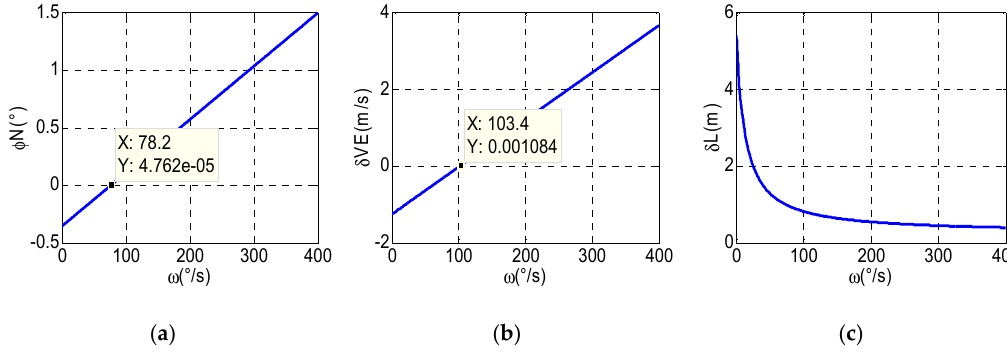
Figure 4. ( a ) The relationship curve of north attitude error and modulation angular rate. ( b ) The relationship curve of east velocity error and modulation angular rate. ( c ) The relationship curve of latitude error and modulation angular rate.